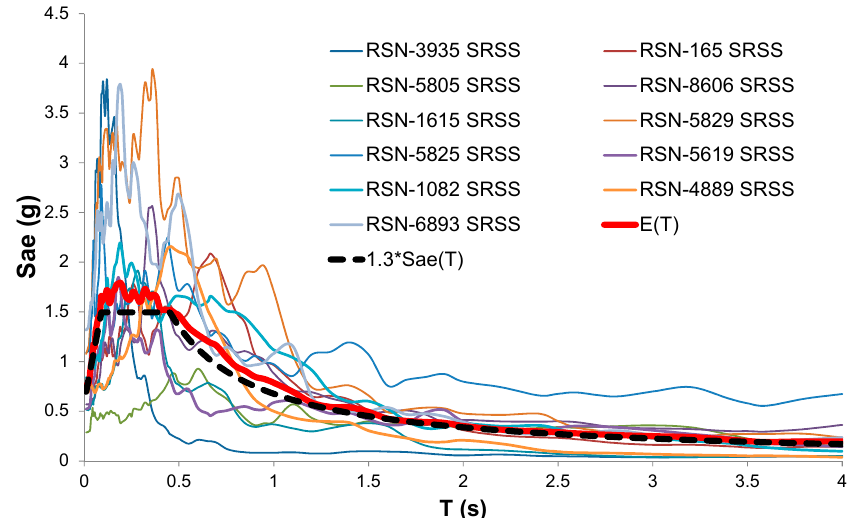
Figure 6. The square root of the sum of the squares (SRSS) spectrum of scaled acceleration records. Table 6. The properties of the selected earthquake records and scaled